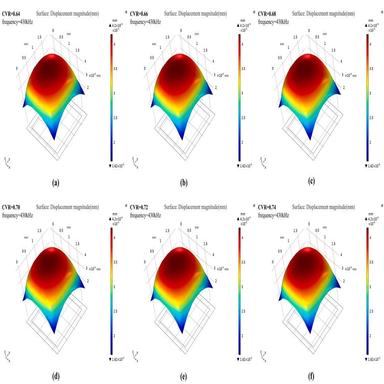
The surface displacement of 1–3 piezoelectric ceramic with various ceramic volume fractions (a) 0.64, (b) 0.66, (c) 0.68, (d) 0.7, (e) 0.72, (f) 0.74.